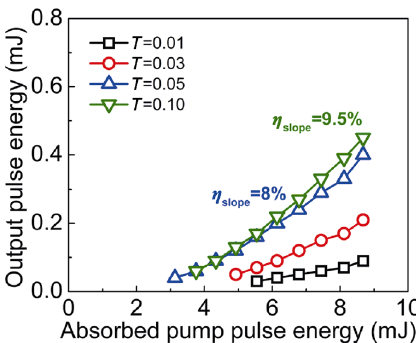
Fig. 14 Laser pulse energy ( E p ) versus the pump pulse absorbed energy ( E abs ) for (Y 0.93 Yb 0.05 La 0.005 Zr 0.015 ) 2 O 3 ceramics vacuum sintered at T = 1800 ℃ for 10 h. The solid lines are linear fits of the experimental